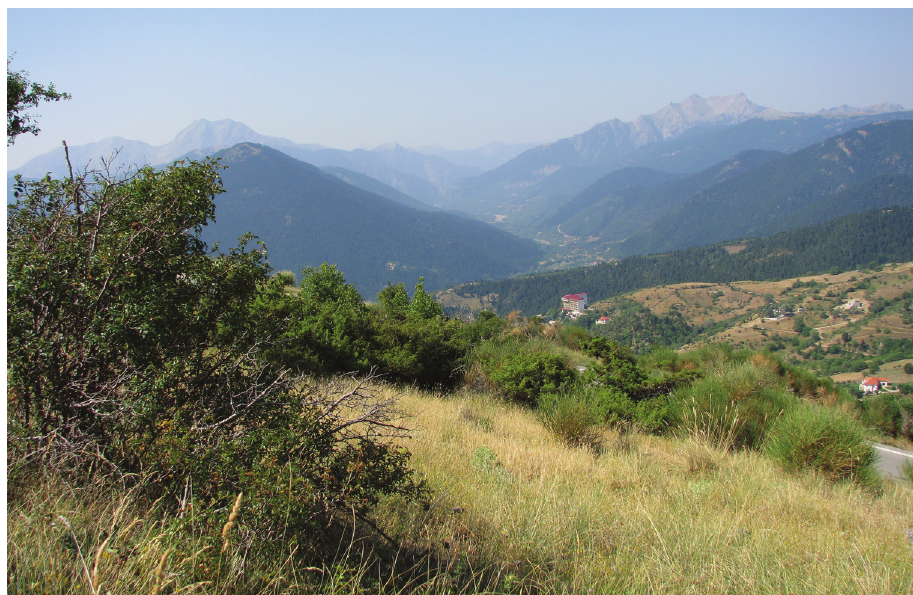
Figure 33. Habitat of P. timfristos . Central Greece, Mt. Timfristos, near Karpenisi, 1200 m, 20 July 2008. Photo by V.A. Lukhtanov.